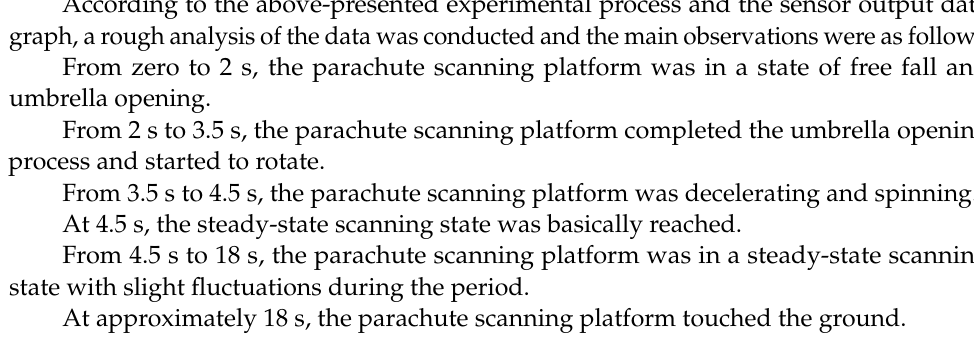
Figure 16. Output data of the three-axis magnetic sensor.